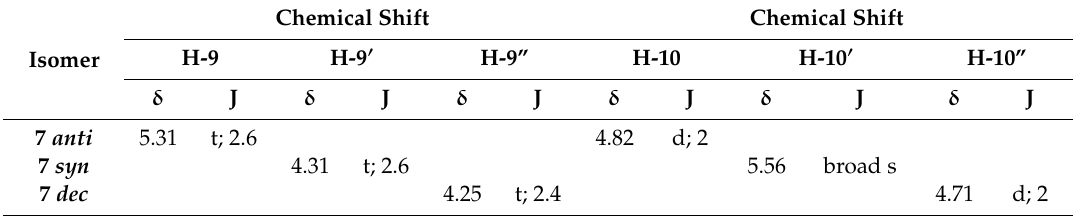
Table 3. The distinguishing between the isomers 7 anti , 7 syn, and 7 dec using chemical shifts. Chemical Shift Chemical Shift H-9 H-9 (cid:48) Isomer